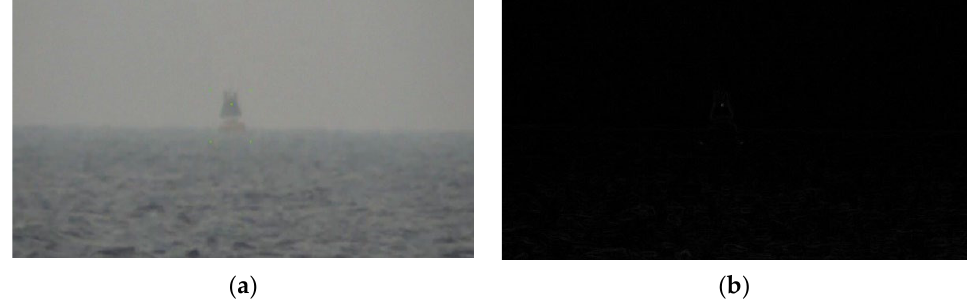
Figure 6. The extraction effect of the traditional Sobel edge detection algorithm: ( a ) A foggy image at sea; ( b ) The image extracted by the Sobel edge detection algorithm.